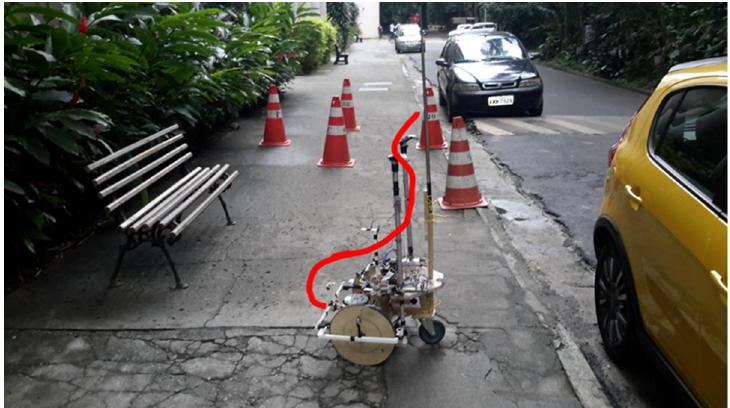
Figure 19. Starting position of route 2.